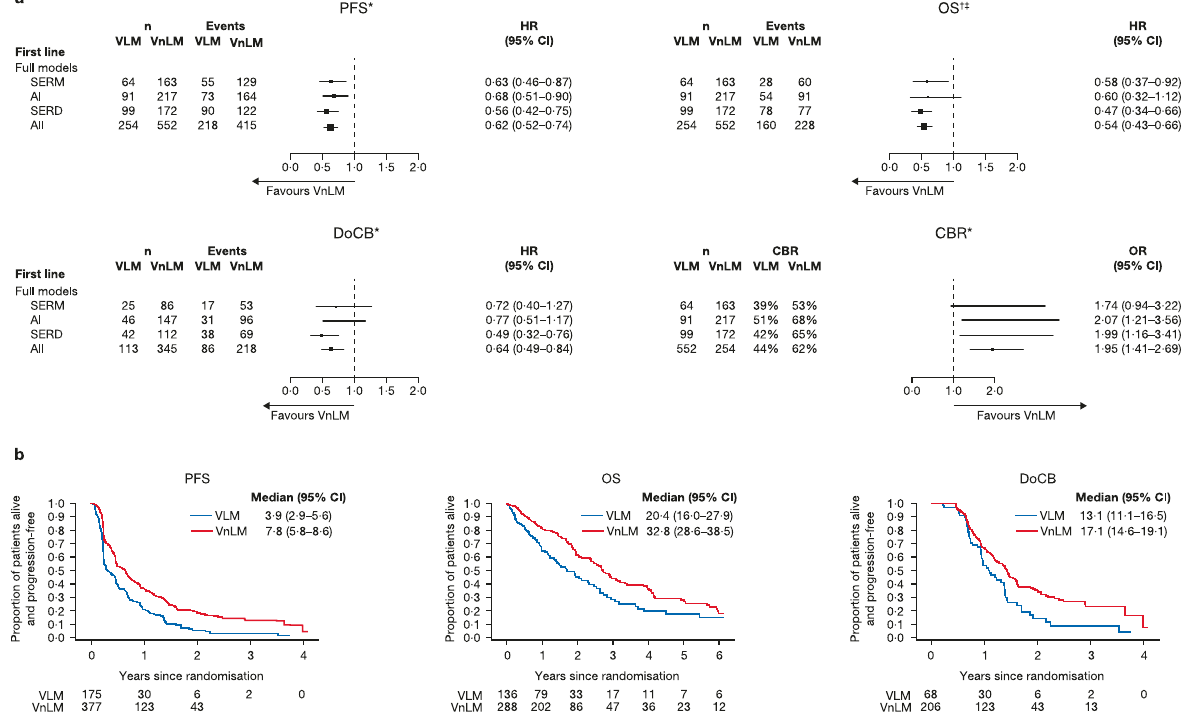
Fig. 3 Clinical outcome measures for VLM versus VnLM in the fi rst-line setting. a Forest plots of PFS, OS, DoCB and CBR. Data for VLM are not available for the EORTC trial. *Fixed effect for trial was fi tted in all models. † Random effect for trial were fi tted in model for AI. ‡ OS data for Study 0027 are based on aggregated mature survival data. b Projected probability of PFS, OS and DoCB. Median (95% CI) PFS/OS/DoCB in months. AI aromatase inhibitor, CBR clinical bene fi t rate, DoCB duration of clinical bene fi t, HR hazard ratio, n number of patients, non-VM non- visceral metastases, PFS progression-free survival, OR odds ratio, OS overall survival, SERD selective estrogen receptor degrader, SERM selective estrogen receptor modulator, VLM visceral liver metastases, VM visceral metastases, VnLM visceral non-liver metastases. Statistics for full models: VLM vs VnLM PFS: SERM: p = 0·005, heterogeneity test p = 0·91; AI: p = 0·008, heterogeneity test p = 0·81; SERD: p < 0.001, heterogeneity test p = 0·95; All: p < 0·001, heterogeneity test p = 0·99. OS: SERM: p = 0·020, heterogeneity test p = 0·89; AI: p = 0·106, heterogeneity test p < 0·05; SERD: p < 0.001, heterogeneity test p = 0·34; All: p < 0·001, heterogeneity test p = 0·24. DoCB: SERM: p = 0·255, heterogeneity test p = 0·93; AI: p = 0·229, heterogeneity test p = 1·00; SERD: p < 0·001, heterogeneity test p = 0·08; All: p = 0·001,